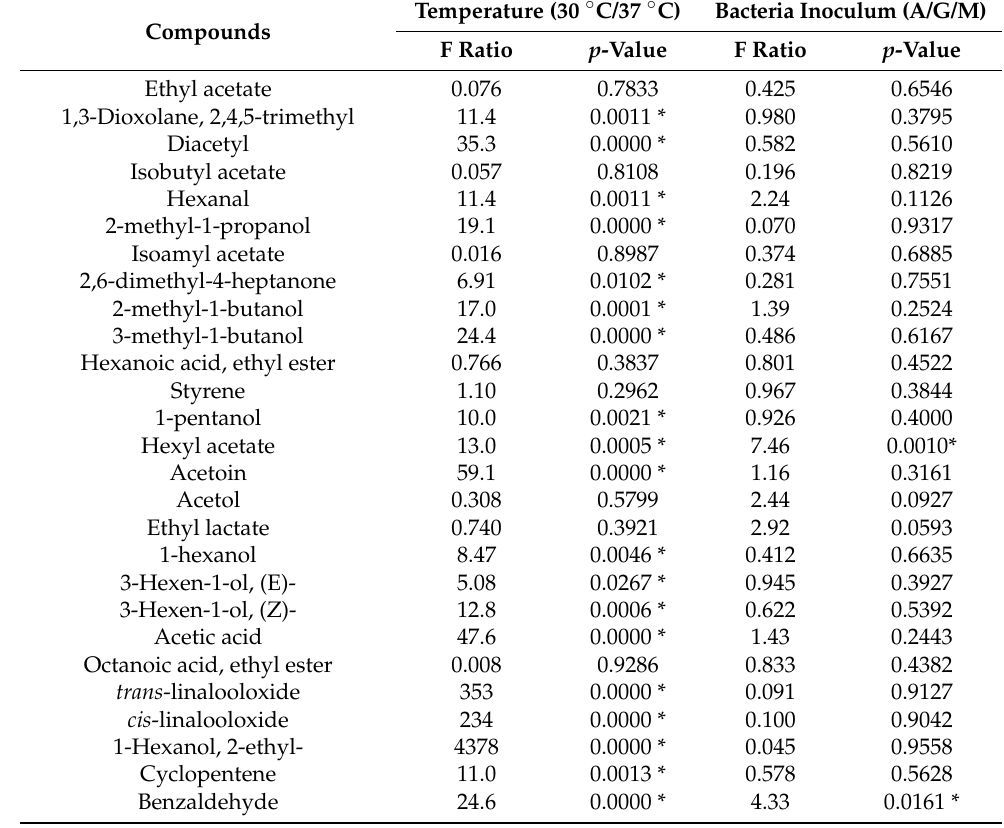
Table 2. Analysis of variance considering the effect of temperature (30 ◦ C/37 ◦ C) and bacteria inoculum ( Acetobacter (A)/ Gluconobacter (G)/Mixture of bacteria (M)) on volatile compounds of prickly pear vinegar produced by surface